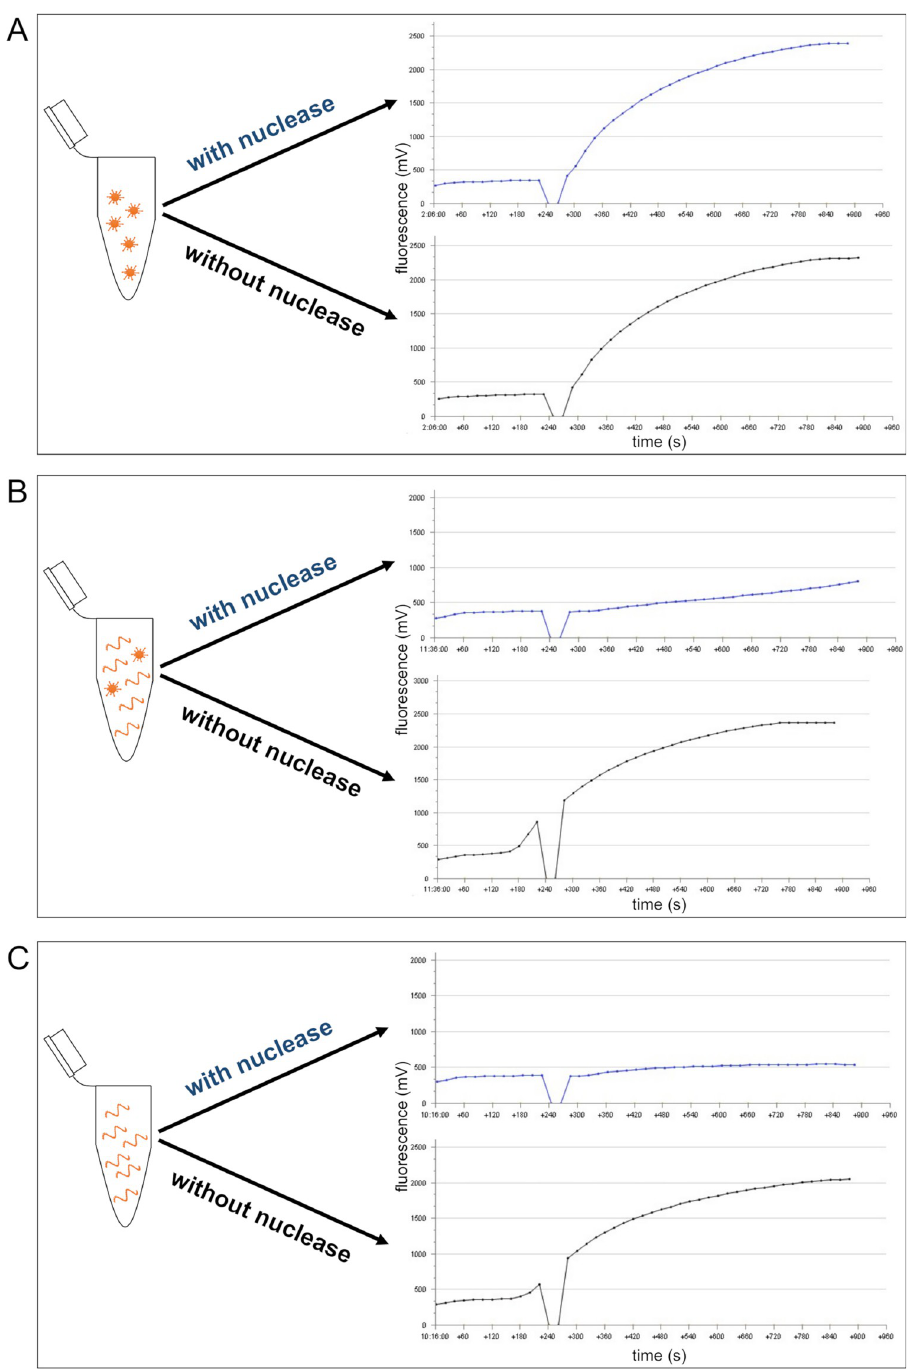
Fig 2. Result outputs by combining nucleases and RT-RAA assay. Pretreatment with nuclease of samples containing only intact virus particles did not interfere with the RT-RAA signals (A). Samples containing both intact virus particles and free NA give different results because the free NA are degraded by the nuclease (B). Samples containing only free NA give no signal when pretreated with nuclease (C).